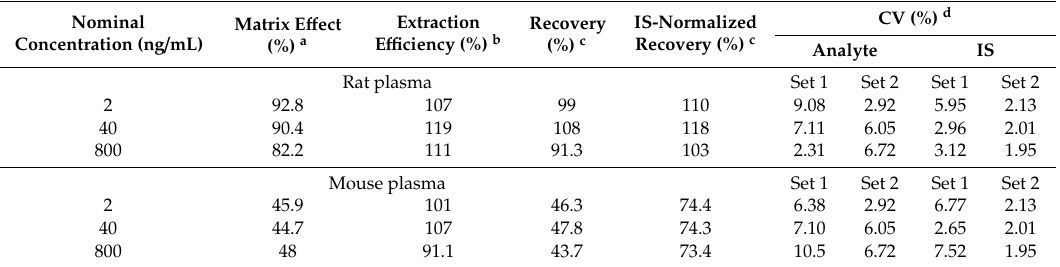
Table 4. Matrix e ff ect, extraction e ffi ciency, and recovery of the assay for SH-1242 determination in rat and mouse plasma